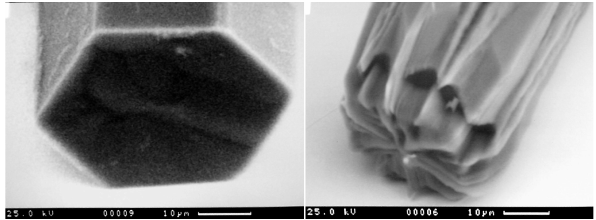
Fig. 12. SEM images of an ice analogue crystal from the same batch as in Fig. 11, before (left) and after approximately 11min of dis- solving (right). Initial crystal diameter was